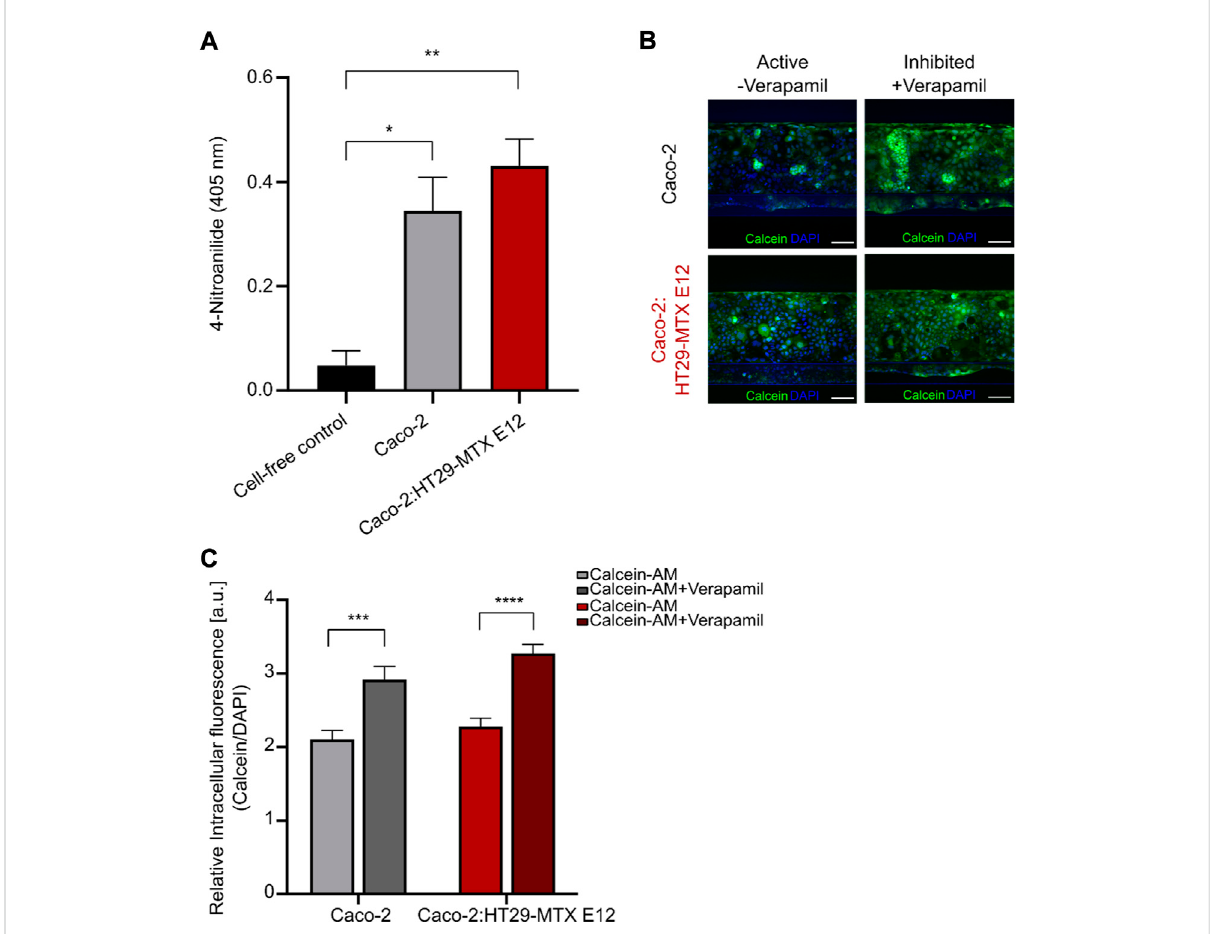
FIGURE 4 Identi fi cation of active intestinal metabolic enzyme and P-gp transporter in mono-and coculture tubules. (A) Brush border enzyme aminopeptidase N quanti fi cation in cell free (black), monoculture (grey) or coculture (red) systems measured as the absorbance of the cleavage product4-Nitroanailide.Errorbarsrepresentthestandarderrorofthemean(SEM)ofatleastthreebiologicalreplicatespercondition(* p < 0.05,** p < 0.005). (B) Left, micrographs depicting the non-inhibited calcein (green) and DAPI (blue) fl uorescence intensities after 1 h incubation for monoculture (top) and coculture (bottom). Right, micrographs depicting the Verapamil-inhibited calcein (green) and DAPI (blue) fl uorescence intensity after 1 h incubation for monoculture (top) and coculture (bottom). Scale bar is 100 µm. (C) Quanti fi cation of the relative intracellular fl uorescence (I relative) innon-inhibitedmonoculture (light grey), Verapamil-inhibitedmonoculture (darkgrey),non-inhibitedcoculture (light red)and Verapamil-inhibited coculture (dark red). Error bars represent the SEM of at least three biological replicates per condition. (* p = 0.047, ** p = 0.0019, *** p = 0.0004, **** p <